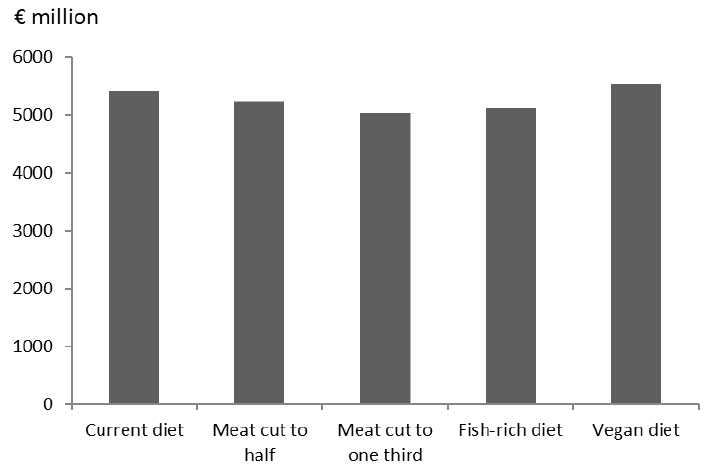
Fig. 3. Food processing industry output (€ million) according to the input- output analysis